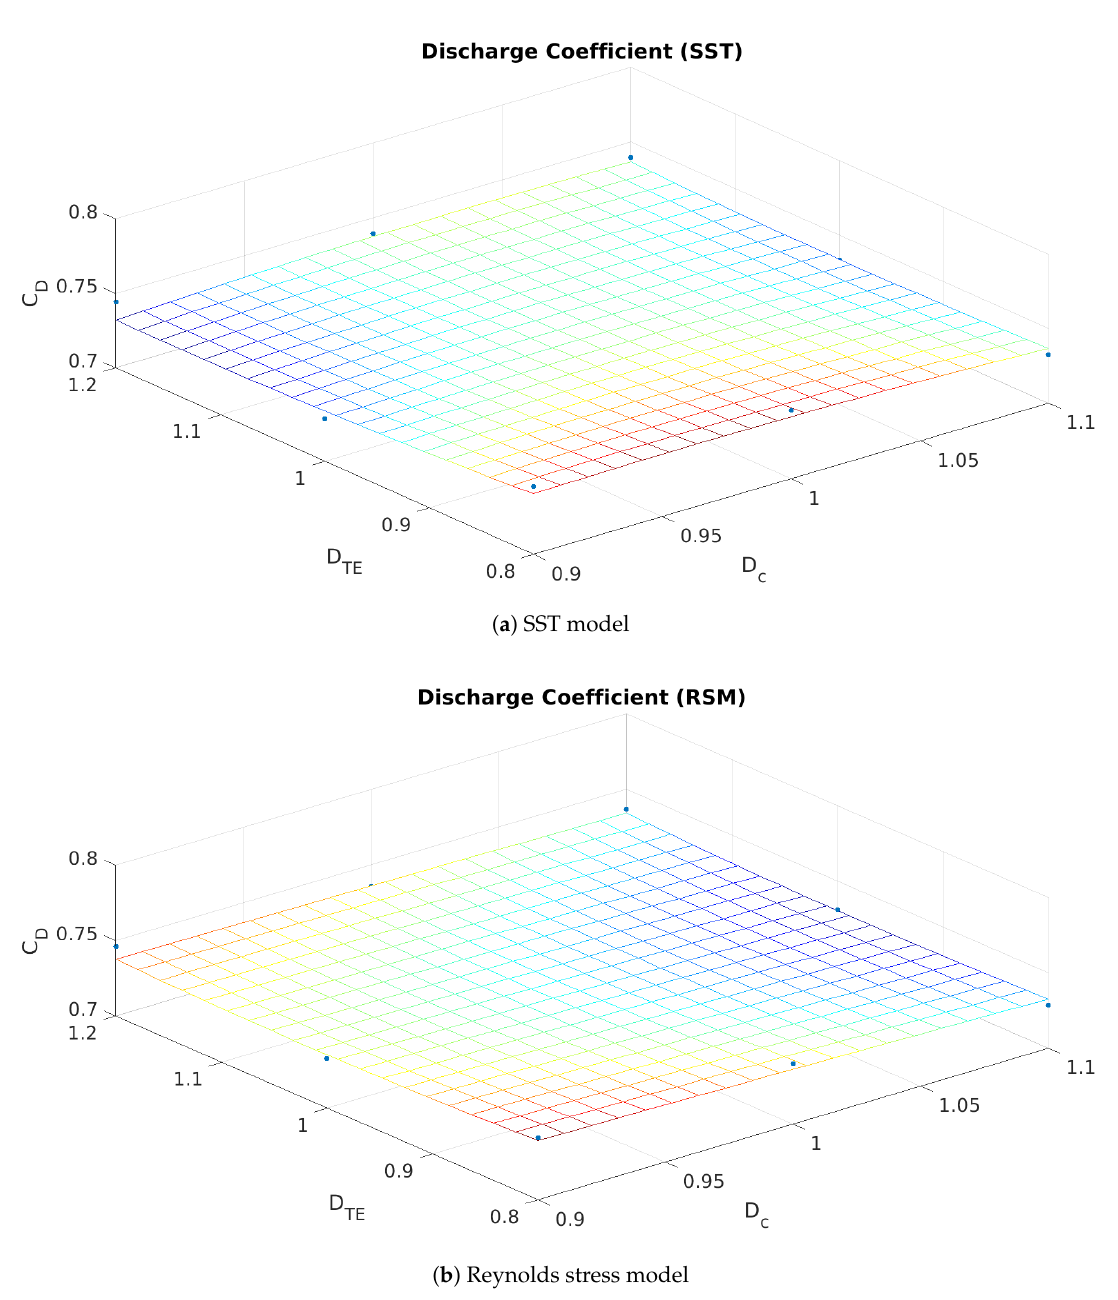
Figure 6. Discharge Coefficient C D (Hermite